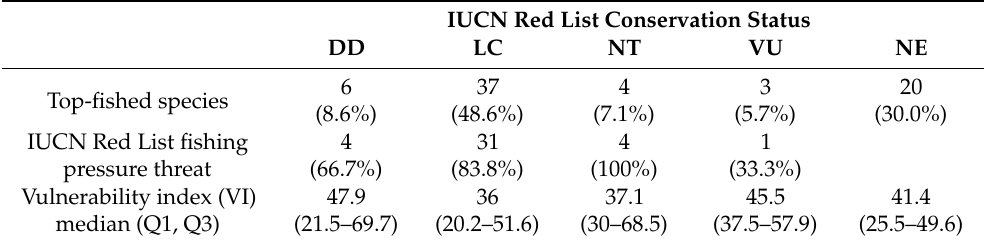
Table 2. Number and percentage of top-fished species assessed in the IUCN Red List, and their population trends and vulnerability indices. IUCN Red List categories: DD (Data Deficient), LC (Least Concern), NT (Near Threatened), VU (Vulnerable), NE (Not